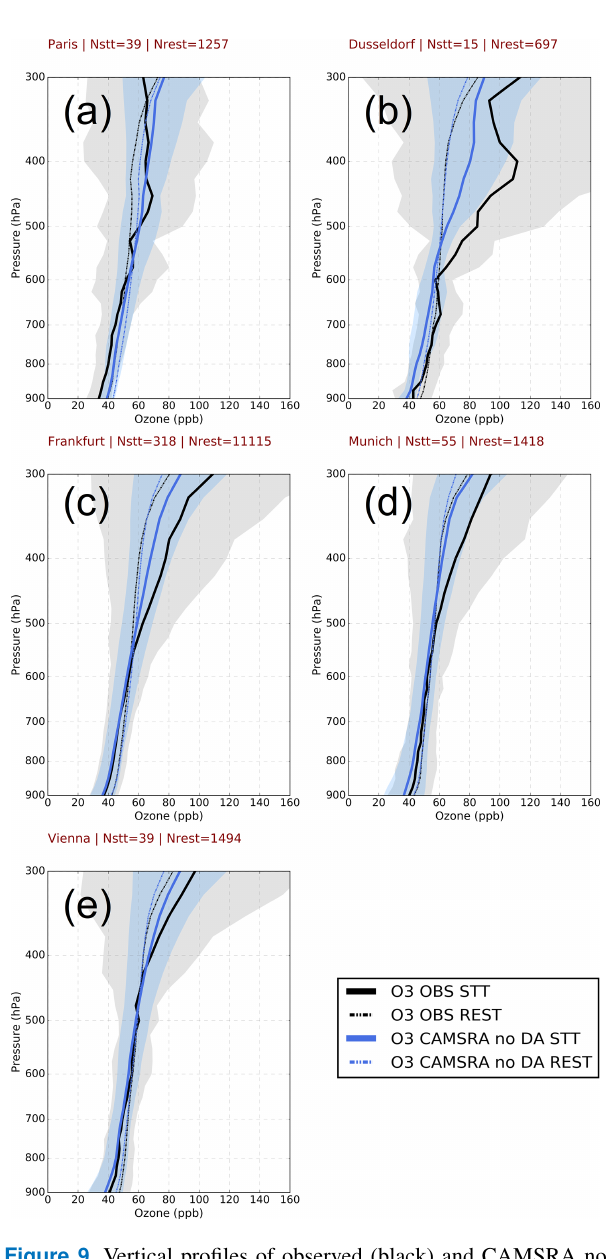
Figure 9. Vertical profiles of observed (black) and CAMSRA no DA (blue) ozone concentrations (ppb) during STT events (thick solid line) and during the rest of the events (thin dashed line) at the IAGOS airports of (a) Paris (France), (b) Düsseldorf (Germany), (c) Frankfurt (Germany), (d) Munich (Germany), and (e) Vienna (Austria). The grey and light blue areas depict the ± 1 standard de- viation of ozone vertical profiles during STT events in observations and CAMSRA no DA, respectively.